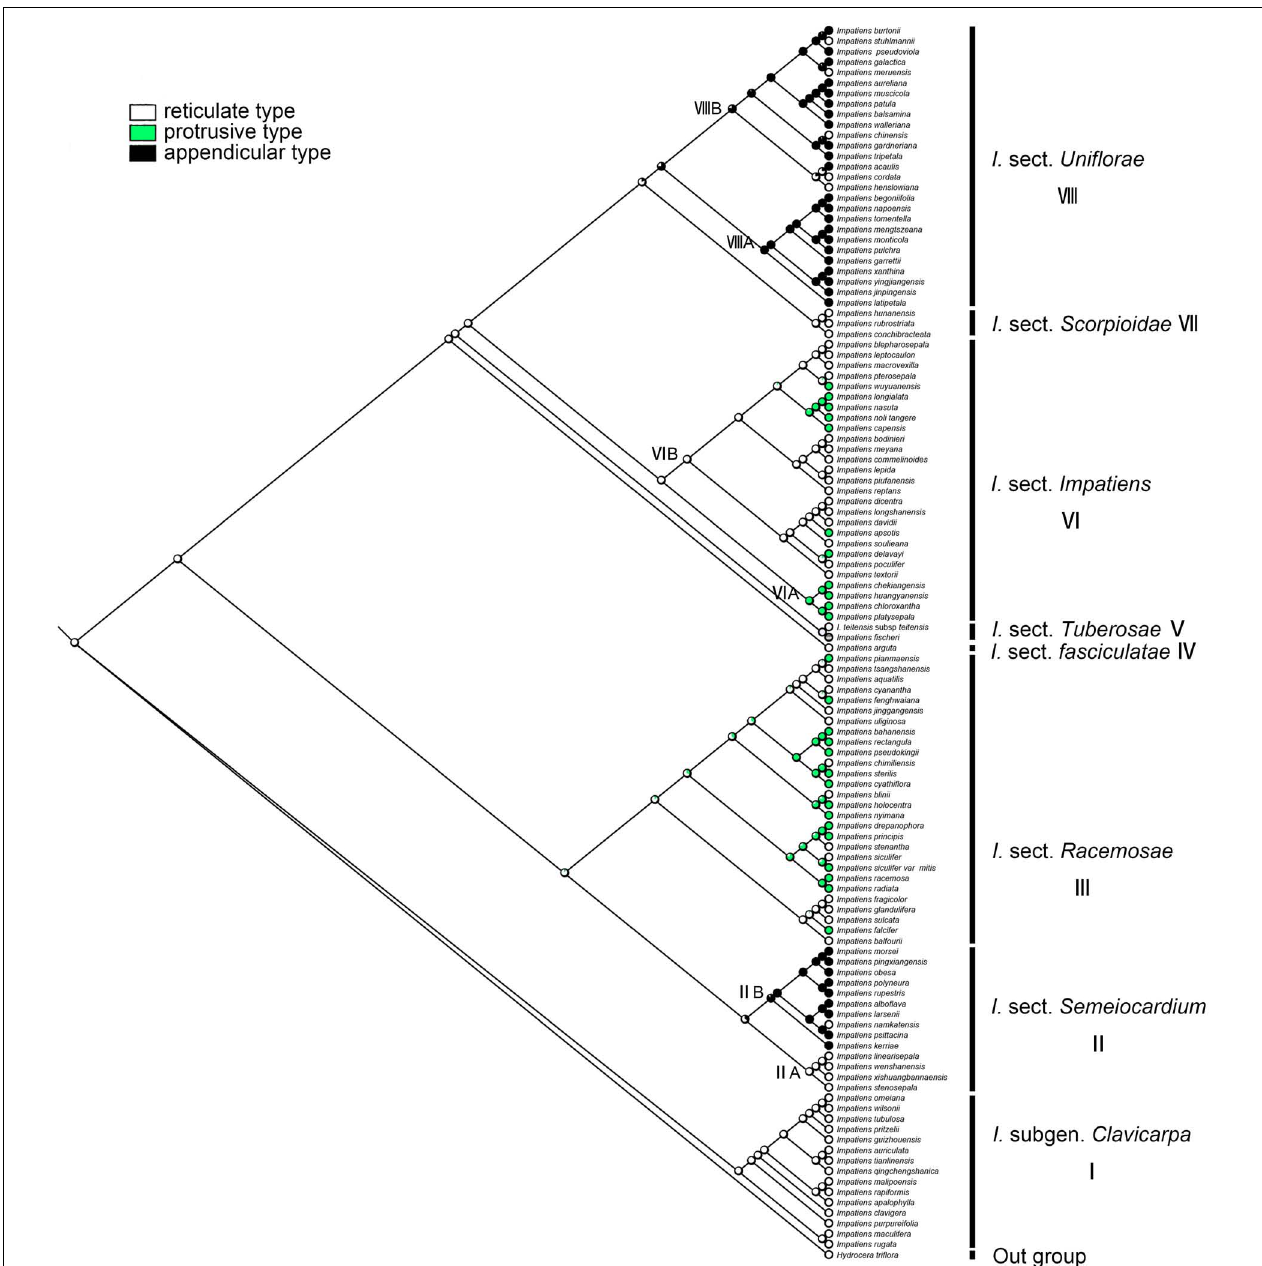
FIGURE 8 | Ancestral reconstruction of the primary ornamentation in Impatiens using ML. Three characteristic states of primary ornamentation of Impatiens optimized on the BI tree by using different colors.